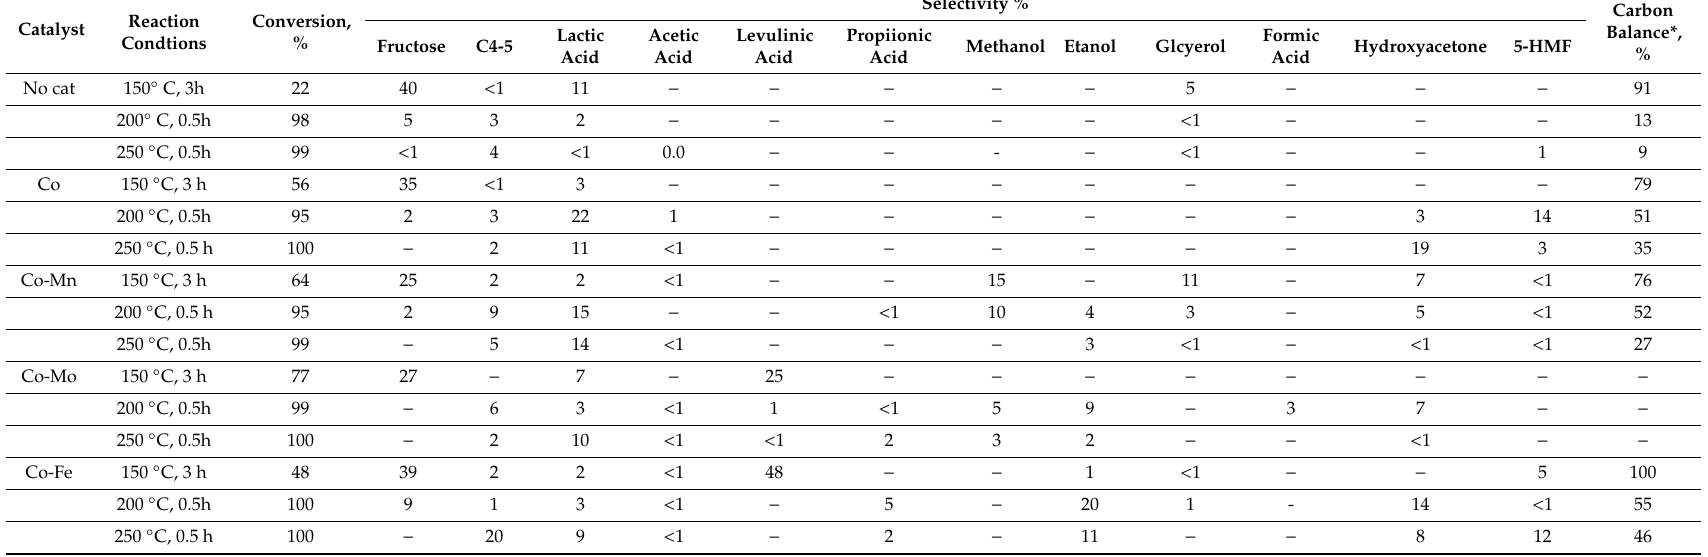
Table 2. Glucose conversion, product selectivity and carbon balance obtained under di ff erent